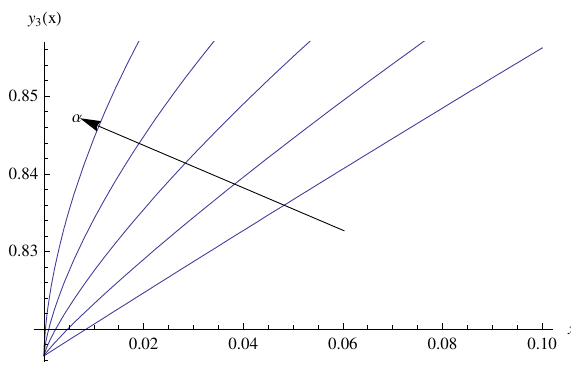
Figure 1. The approximate solution for α = 0.6, 0.7, 0.8, 0.9, 1.